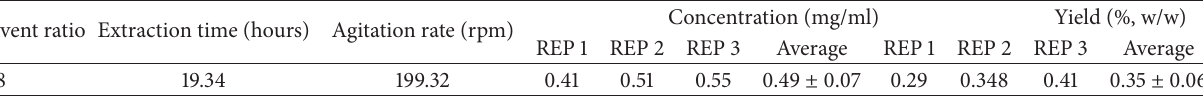
Table 7: Processing parameters used in the rotenone extraction